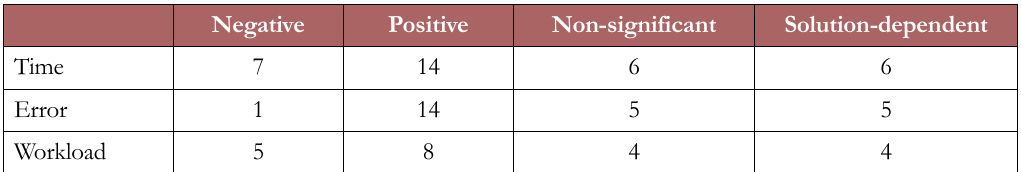
Table 3. Impacts of augmented reality on worker’s